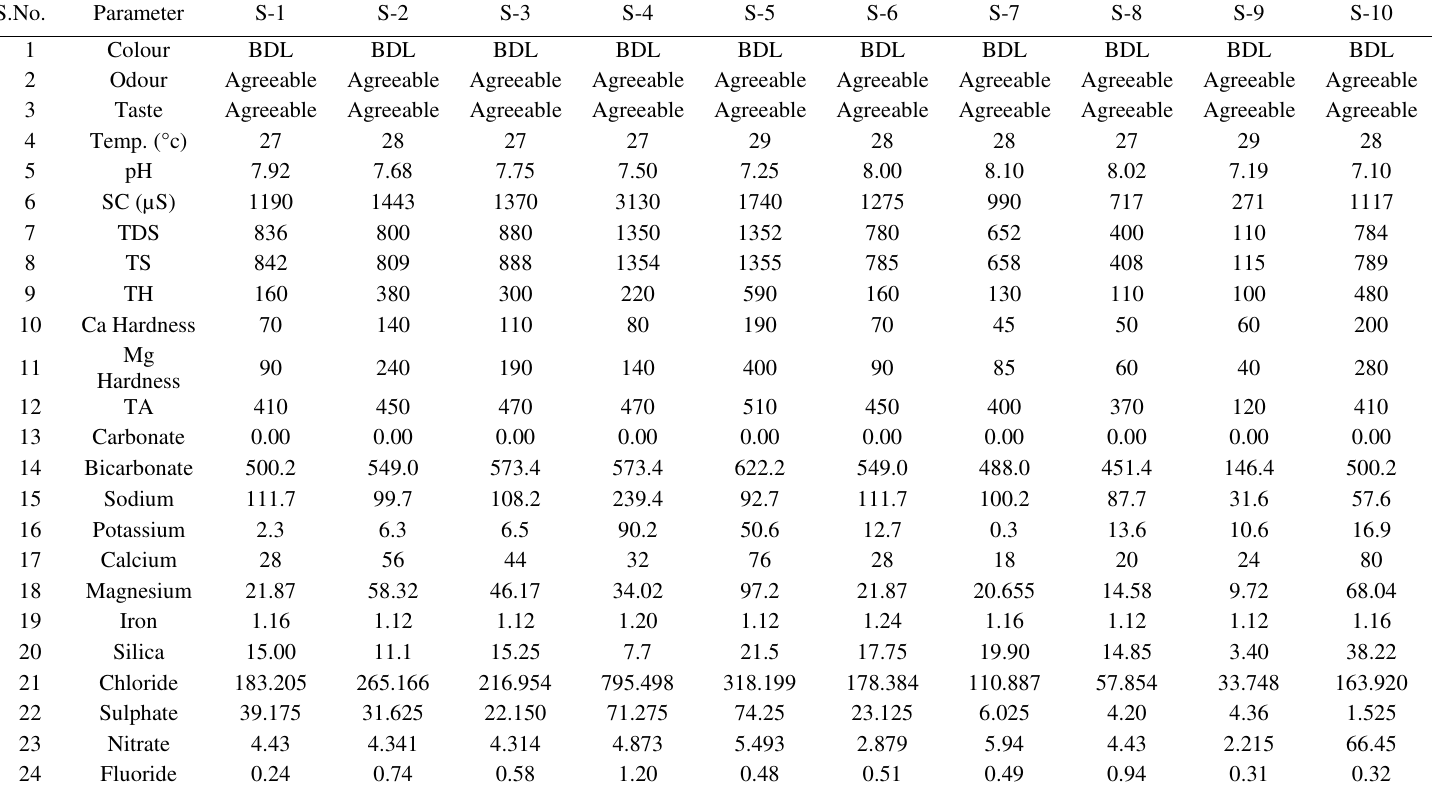
Table-2 Physico-chemical analysis report of Potable waters in AUGUST-2004